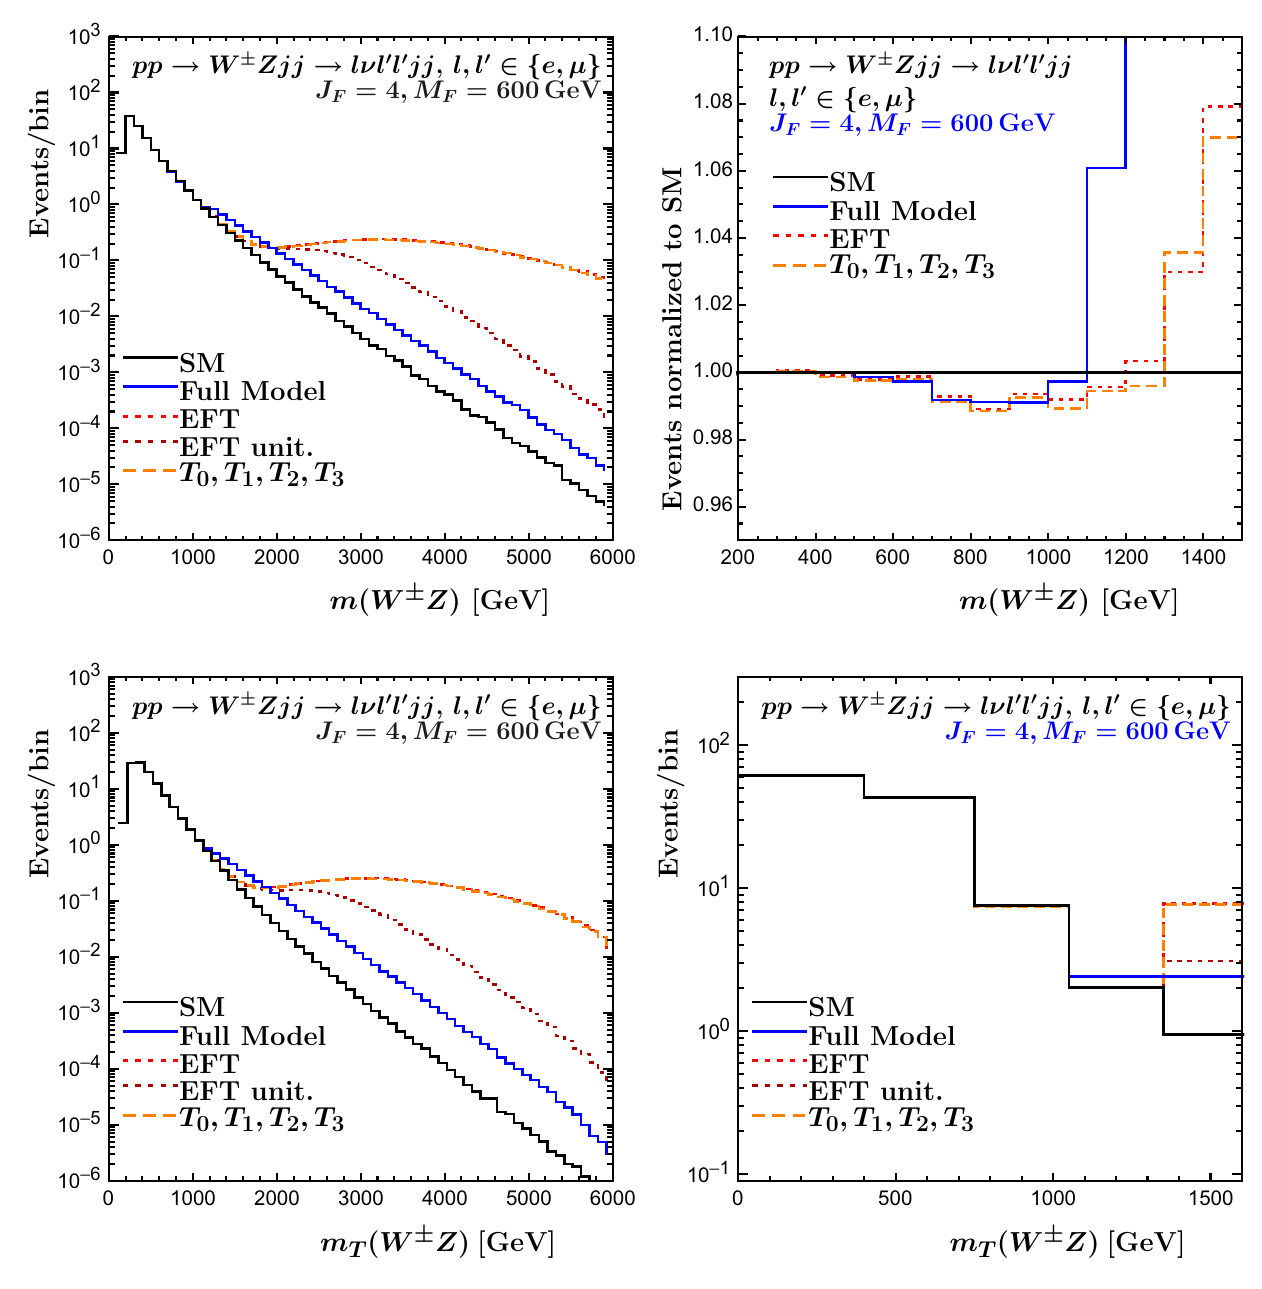
Fig. 10 Same as Fig.9, but for a fermionic multiplet with J F = 4 and M F = 600GeV